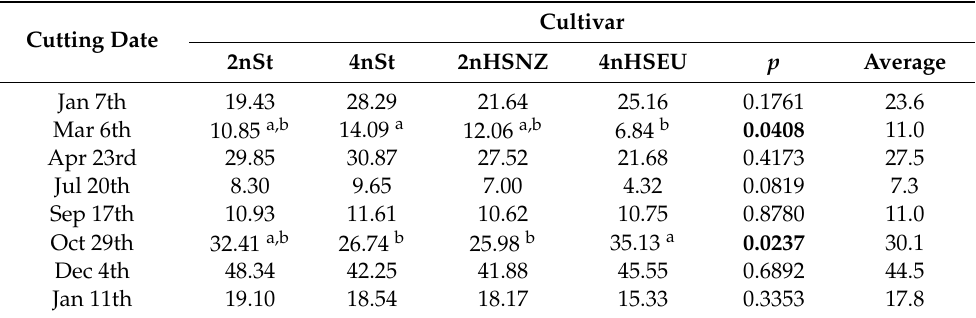
Table 3. Growth rate (kg DM ha − 1 d − 1 ) of four Lolium perenne L. cultivars under a defoliation regime